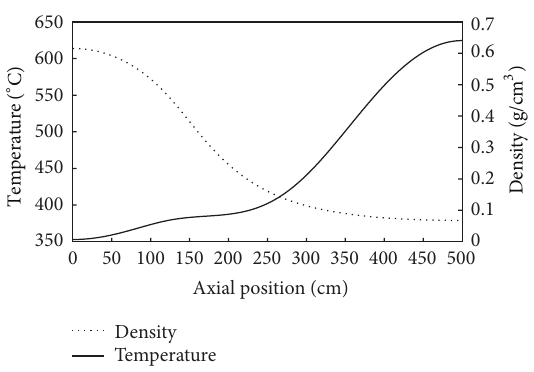
Figure 1: Expected coolant conditions along a Canadian SCWR fuel channel.